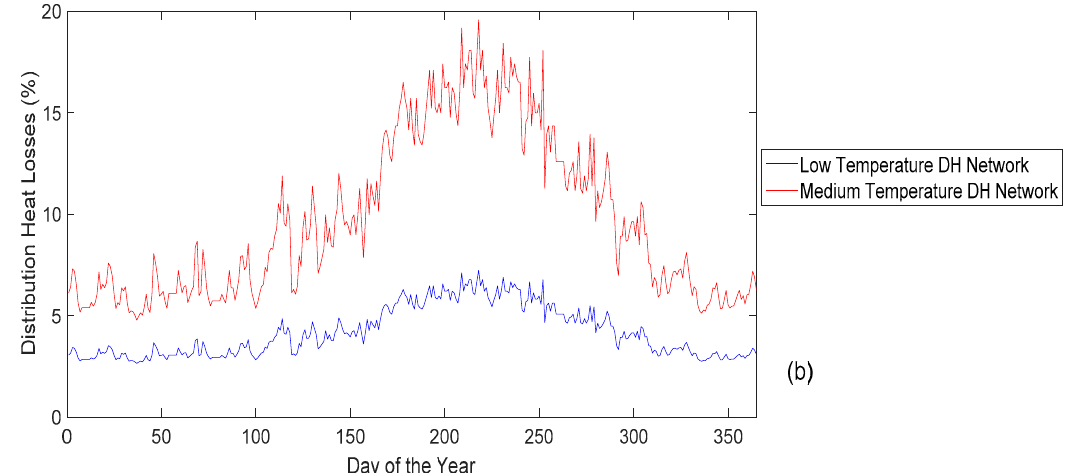
Figure 5. ( a ) Percentage of distribution heat losses for medium and low temperature DH networks as function of thermal demand, ( b ) Percentage of distribution thermal losses in the medium and low temperature DH networks along the year.